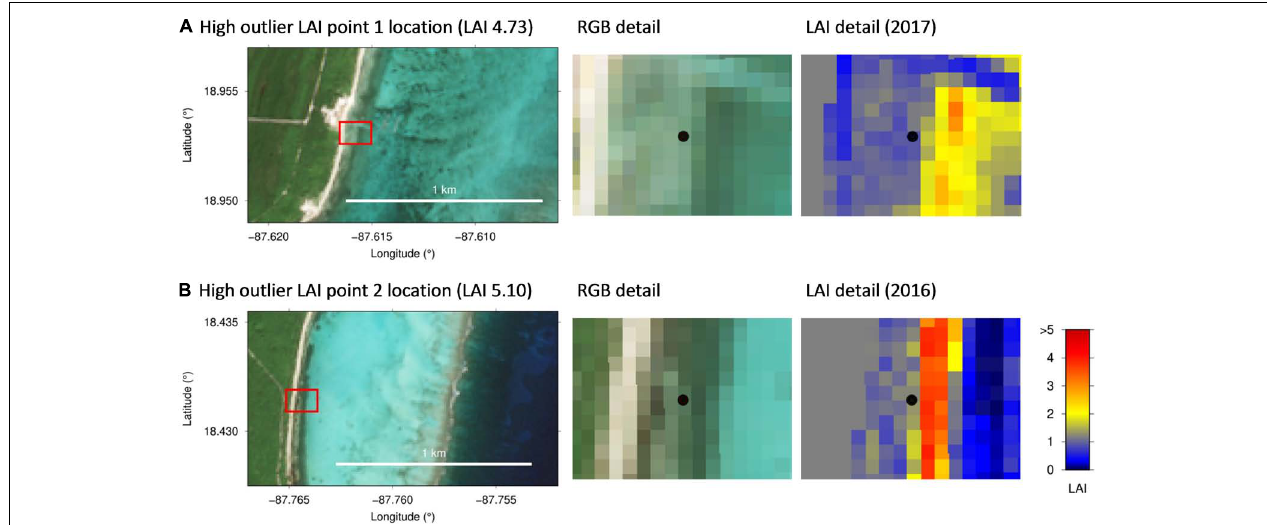
FIGURE 7 | Detail of the two outlier points with LAI greater than 4, as shown in Figure 6 : (A) point 1, (B) point 2. Left images show the general location of each data point in the imagery, the red rectangle represents the area shown in detail in the images on the right. The dot in the centre of the detailed images is the location of the point, pixels are 10 m × 10 m. The RGB images are Sentinel-2 bands B04, B03, and B02 and are from 13 December 2017. LAI images are the year-median results for the year each data point was collected